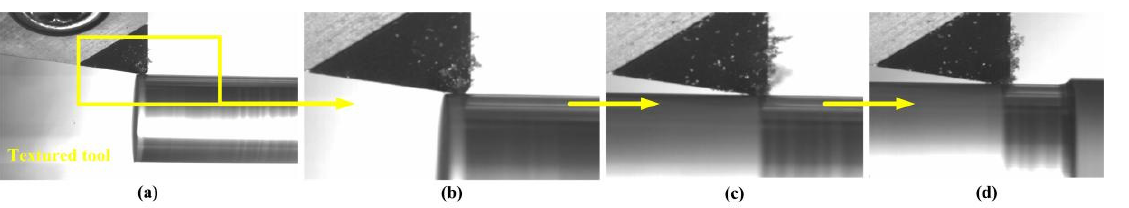
Figure 14. Snapshots of turning by non-textured tool. ( a – d ) show the chips in different turning time.